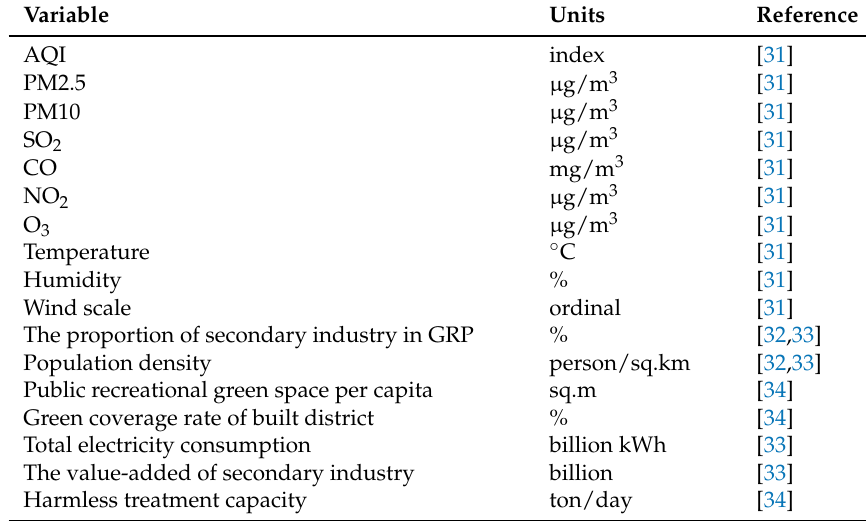
Table 1. Variables description.